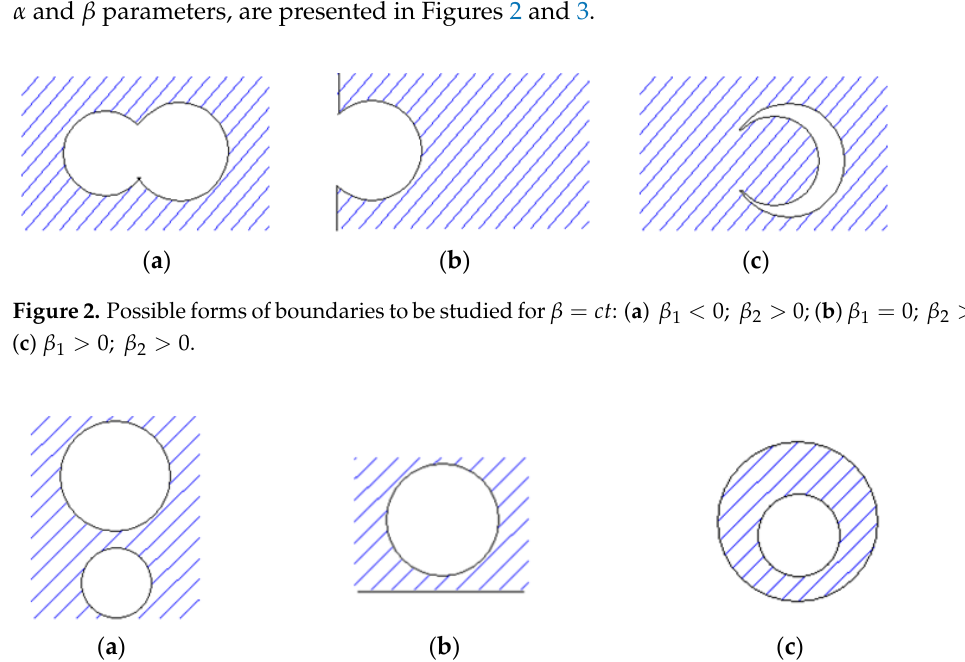
Figure 3. Possible forms of boundaries to be studied for α = ct : ( a ) α 1 > 0; α 2 < 0; ( b ) α 1 > 0; α 2 = 0; ( c ) α 1 > 0; α 2 > 0.